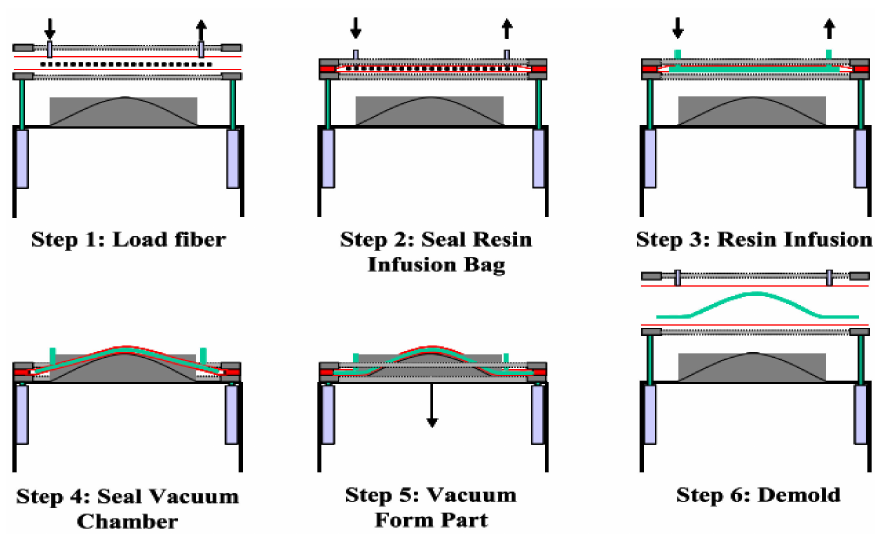
Figure 16. Schematic of the RIDFT Process [139]. Reprinted with permission from